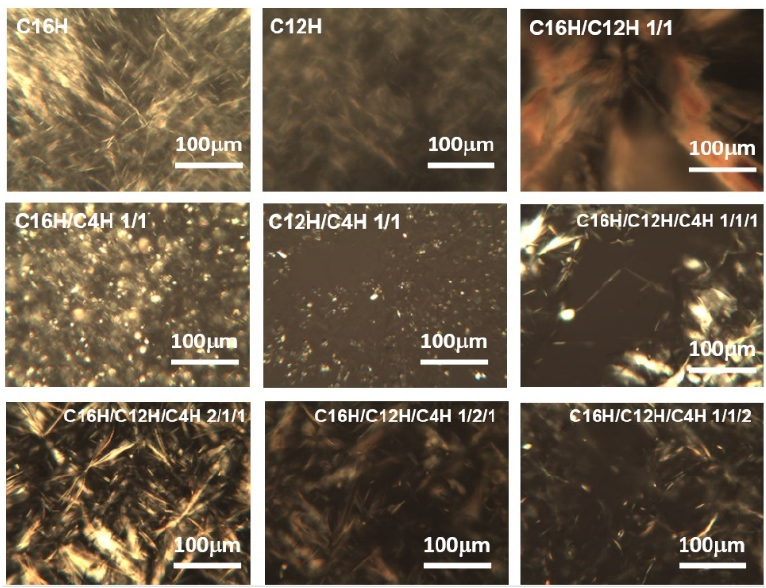
Figure 6. POM photos of the single and mixed molecular gels (solvent: squalane) under the crossed nicols.